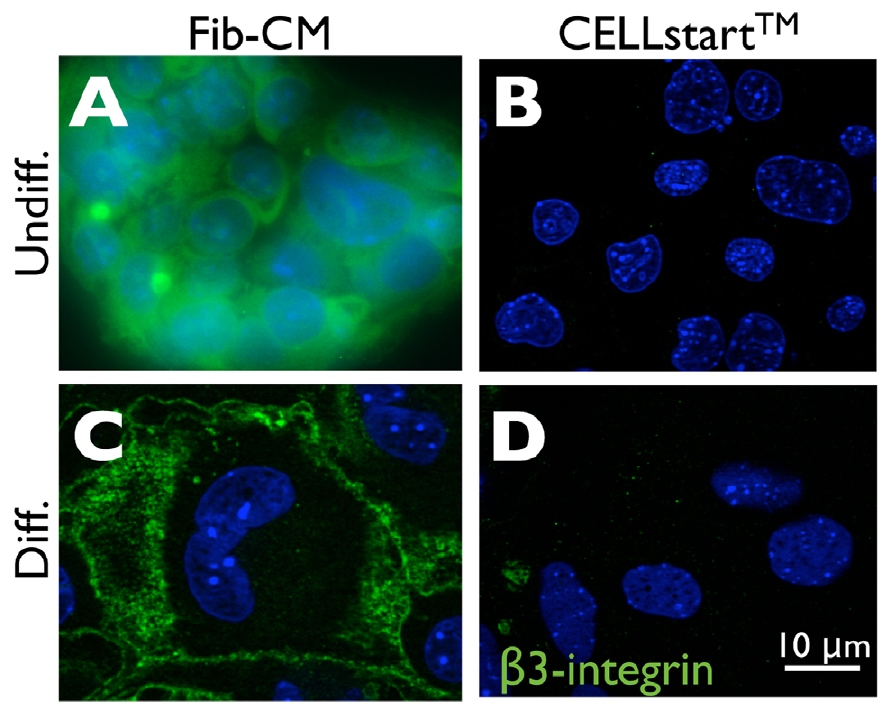
Figure 2. b 3-Integrin (CD61) is downregulated in TSCs following culture on CELLstart TM . Immunofluoresce microscopy of wild-type TSCs maintained on TC plastic in Fib-CM (A) or on CELLstart TM (B) in the presence of FGF4 and heparin (Undiff.) or following differentiation (Diff., C and D) using an anti-CD61 antibody (green) (magnification 630X).